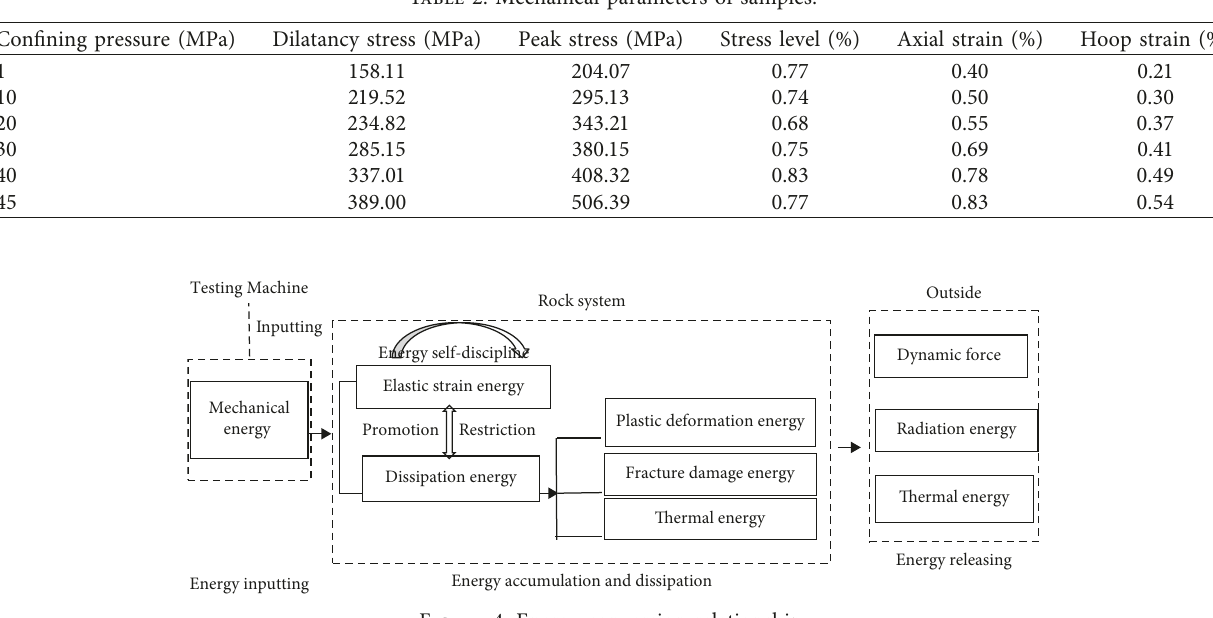
Figure 4: Energy conversion relationship.